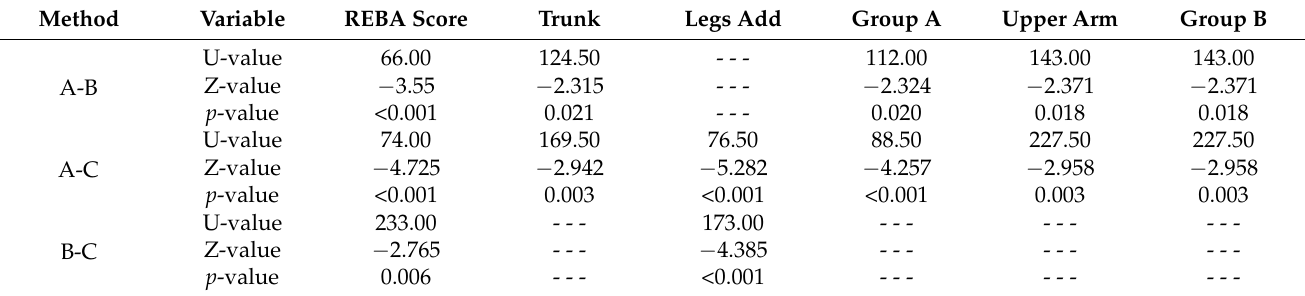
Table 4. The Mann-Whitney U test results for chainsaw worker postural load assessment.